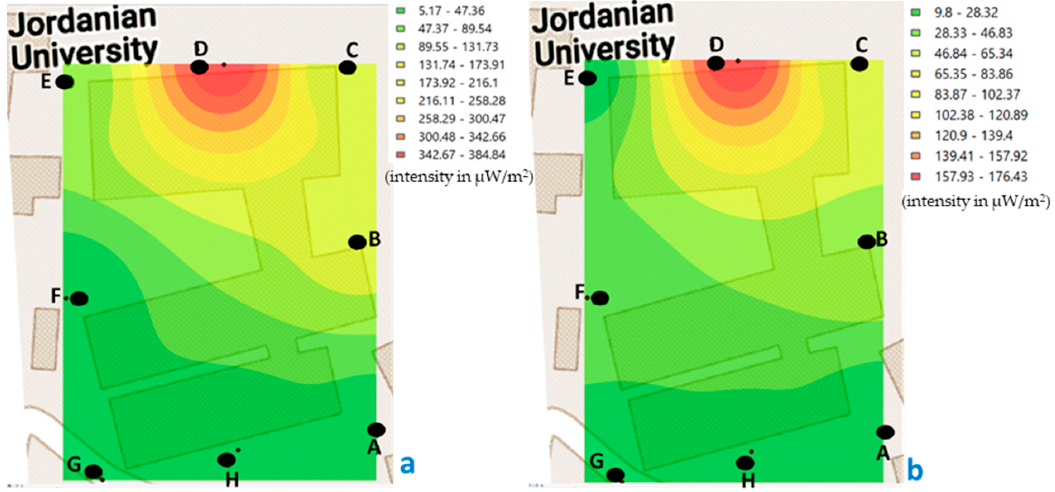
Figure 8. Georeferenced map with the levels of exposure registered in building C (classrooms and laboratory, points A to H), in the afternoon. ( a ) weekend and ( b ) during the week ( μ W/m 2 ).